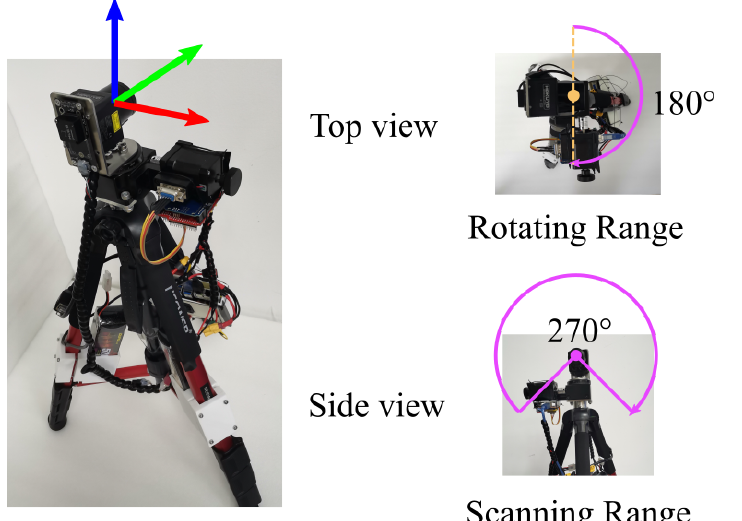
Figure 6. The custom-made laser scanning system. The primary sensor is the Hokuyo UST-30LX laser scanner, which covers a wide field of view 270 ◦ ∗ 180 ◦ .